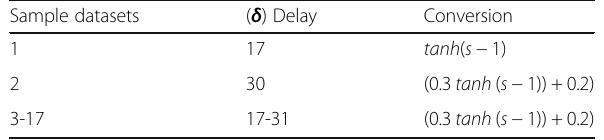
Table 3 Mackey-Glass training and testing datasets Sample